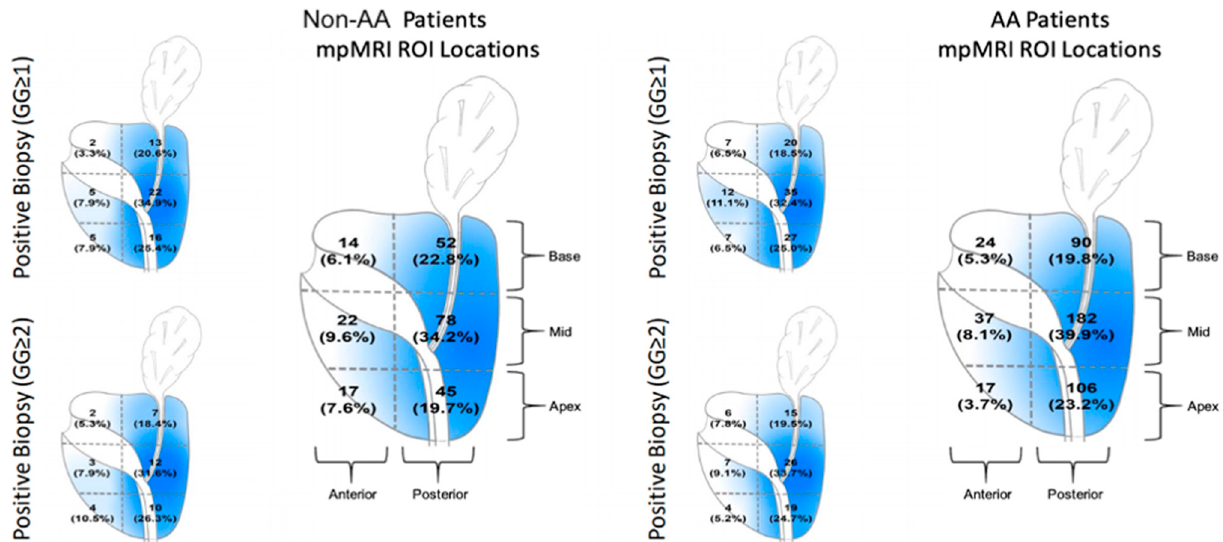
Figure 1. Heatmap illustrating ROI lesions found on mpMRI and positive detection for GG ≥ 1 and GG ≥ 2 between racial groups. Rates of ROI, GG ≥ 1, and GG ≥ 2 per prostate lobe location were statistically comparable between racial groups. Table 3. Overall analysis of racial composition, PIRADS location, and prostate cancer detection. The number of positive ROI biopsies with Gleason grade ≥ 1 and ≥ 2 were statistically comparable between racial groups. AA ROI Location